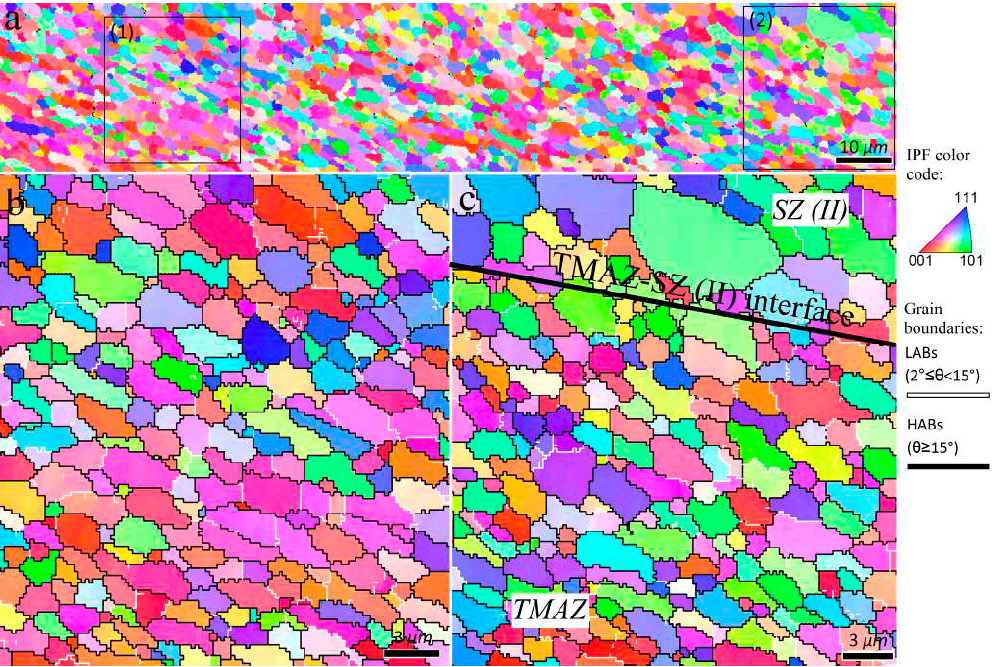
Figure 8. Inverse pole figure maps of the area indicated by rectangle 1 in Figure 7. Higher magnified views of zones 1 and 2 indicated in ( a ) are illustrated in ( b ) TMAZ and ( c ) interfacial area between TMAZ and SZ-II,